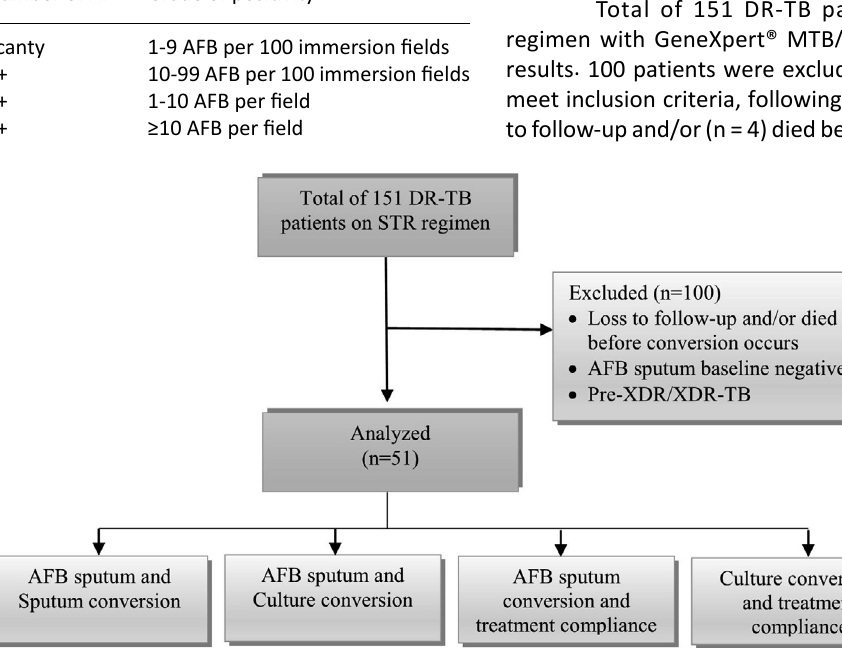
table 1. Positivity of AFB sputum Number of AFB Grade of positivity